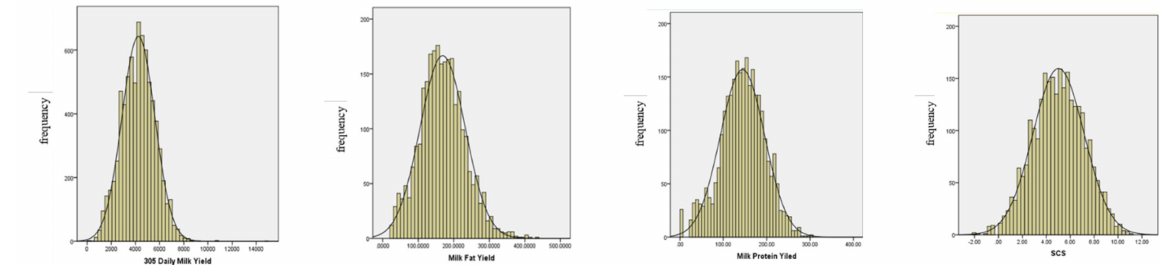
Figure 1. Frequency distribution of phenotypic data of Xinjiang Brown